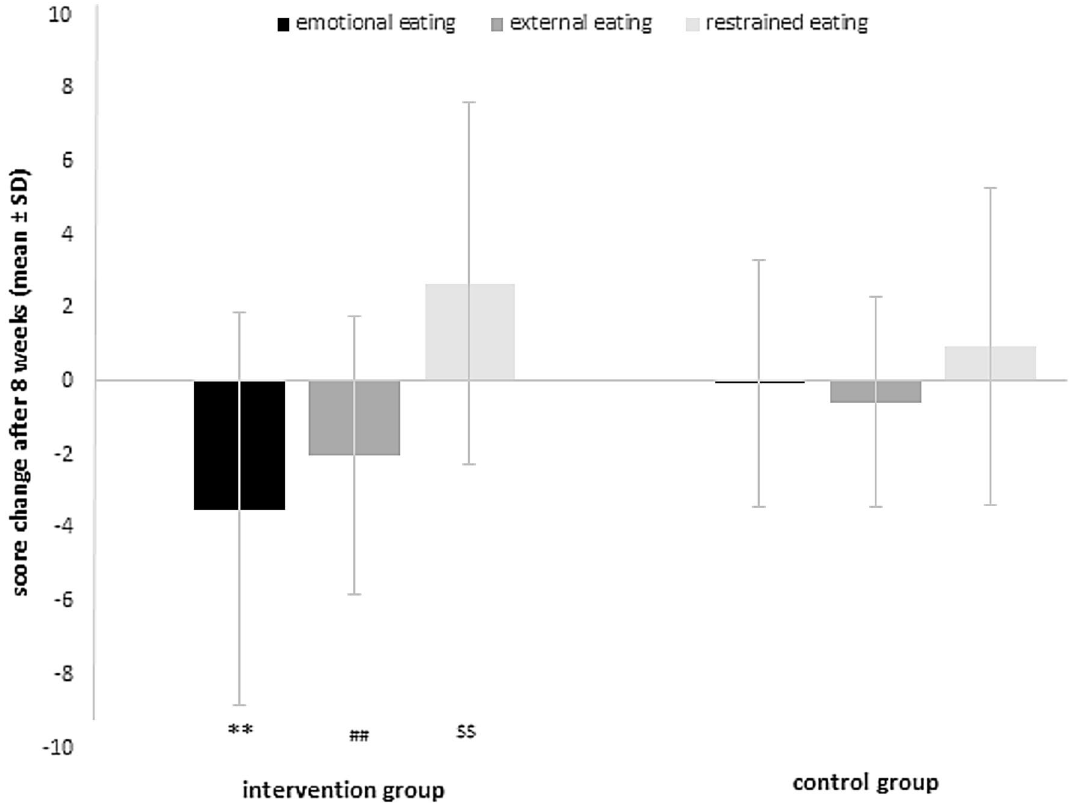
Figure 2. Change of stress-related eating behaviour in the intervention group (IG) and control group (CG); Changes of stress-eating scores: emotional eating: IG = − 3.5 ± 5.4 points (P); CG = − 0.05 ± 3.4 P; external eating: IG = − 2.0 ± 3.8 P; CG = − 0.6 ± 2.9 P; restrained eating: IG = 2.7 ± 5.0 P; CG = 1.0 ± 4.3 P. legend: ** ,##,$$ p < 0.001. compared to baseline; **p < 0.001, ## p = 0.042, $$ p = 0.024 compared to